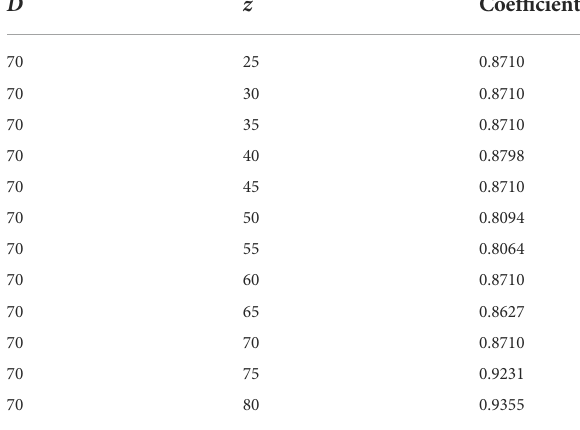
TABLE 4 Coef fi cients obtained by statistical